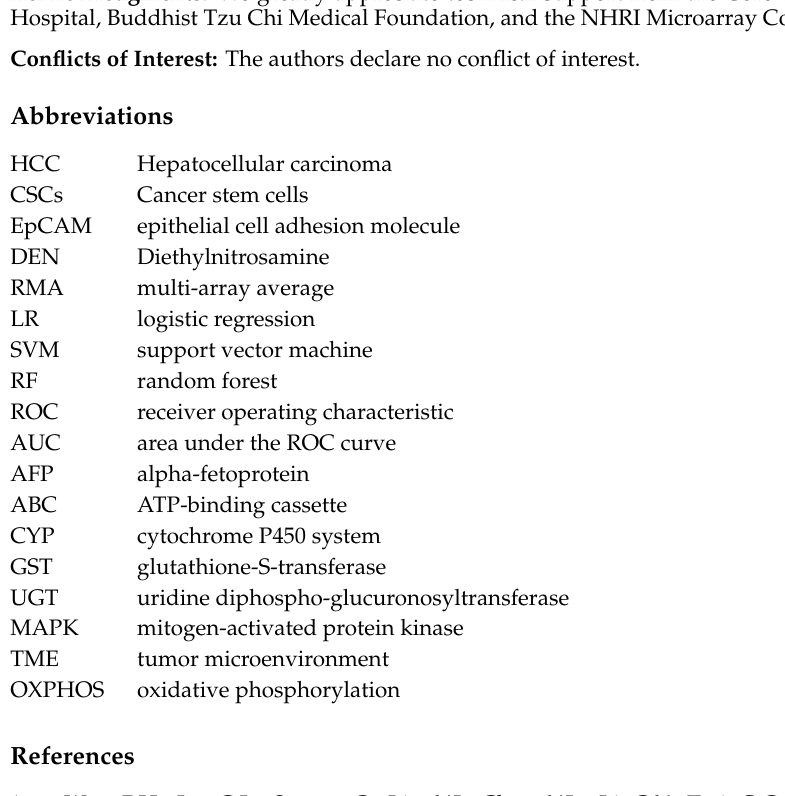
Figure S1: Tumorigenesis of various HCC originated from the DPPIV deficient F344 rats, The scheme of DEN, Figure S2: The original western blot pictures, Figure S3: Various cell linages were di ff erentiated by TW 1 cells after cell culture, Figure S4: TW 1 derived tumors showed invasion in lymph nodes (A) and metastases to the lungs